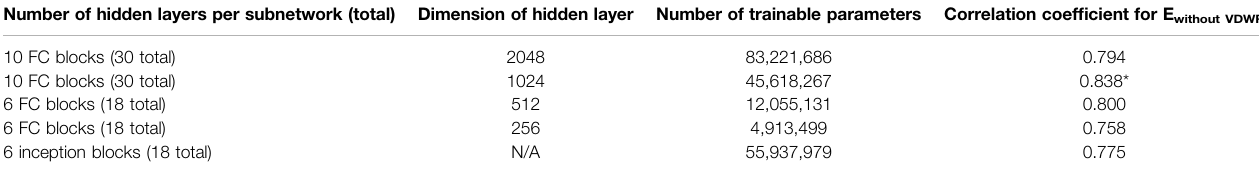
TABLE 1 | Correlation coef fi cients of NeuralDock predicted minimum energy and MedusaDock output for a variety of architectures. Number of hidden layers per subnetwork (total) Dimension of hidden layer Number of trainable parameters Correlation coef fi cient for E without VDWR 10 FC blocks (30